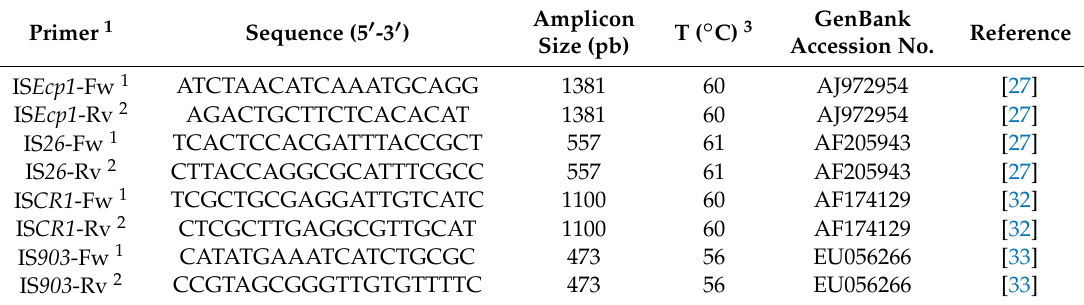
Table 3. Primers and conditions used for the amplification of insertion